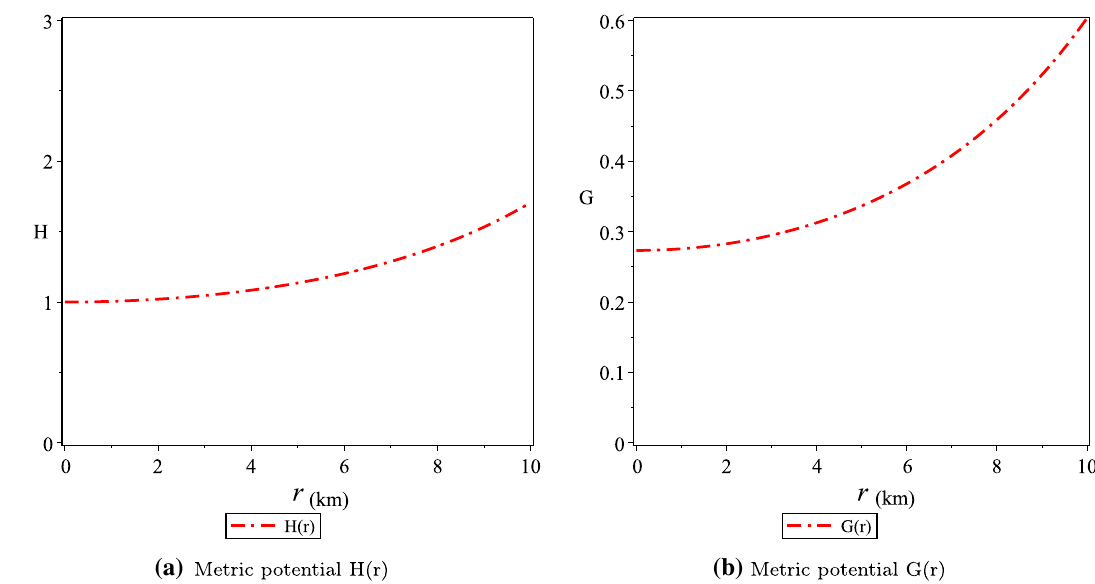
Fig. 1 Schematic plots of the metric potentials (21) and (25) vs the radial coordinate r in Km using the constants constrained by PSR J 1614-2230 data